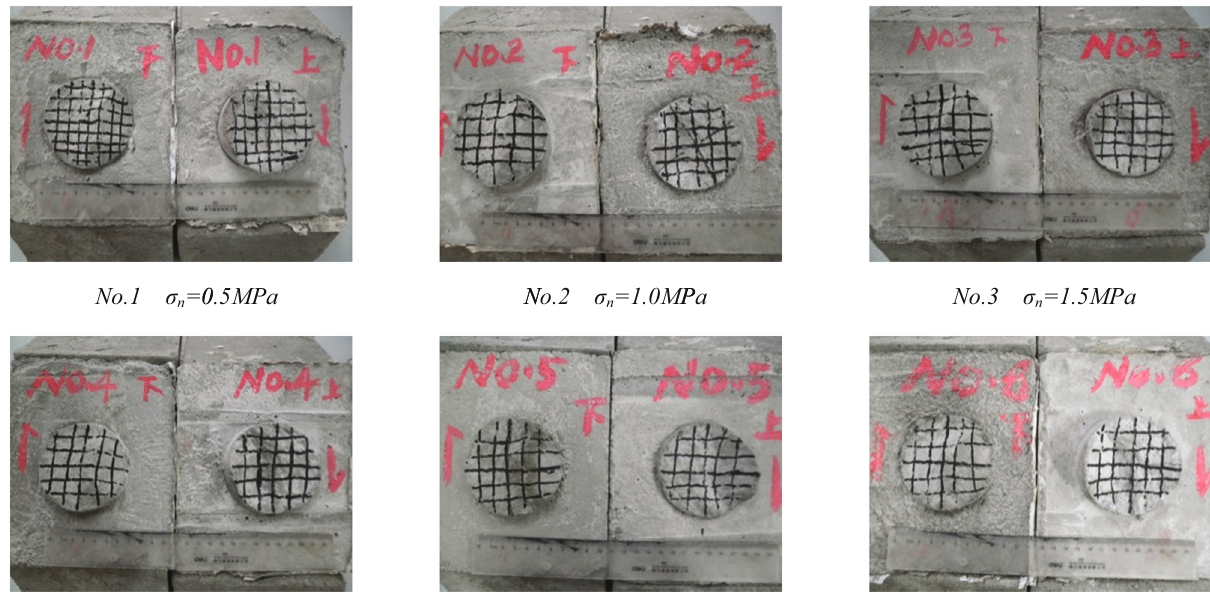
Figure 14: Model of structural plane